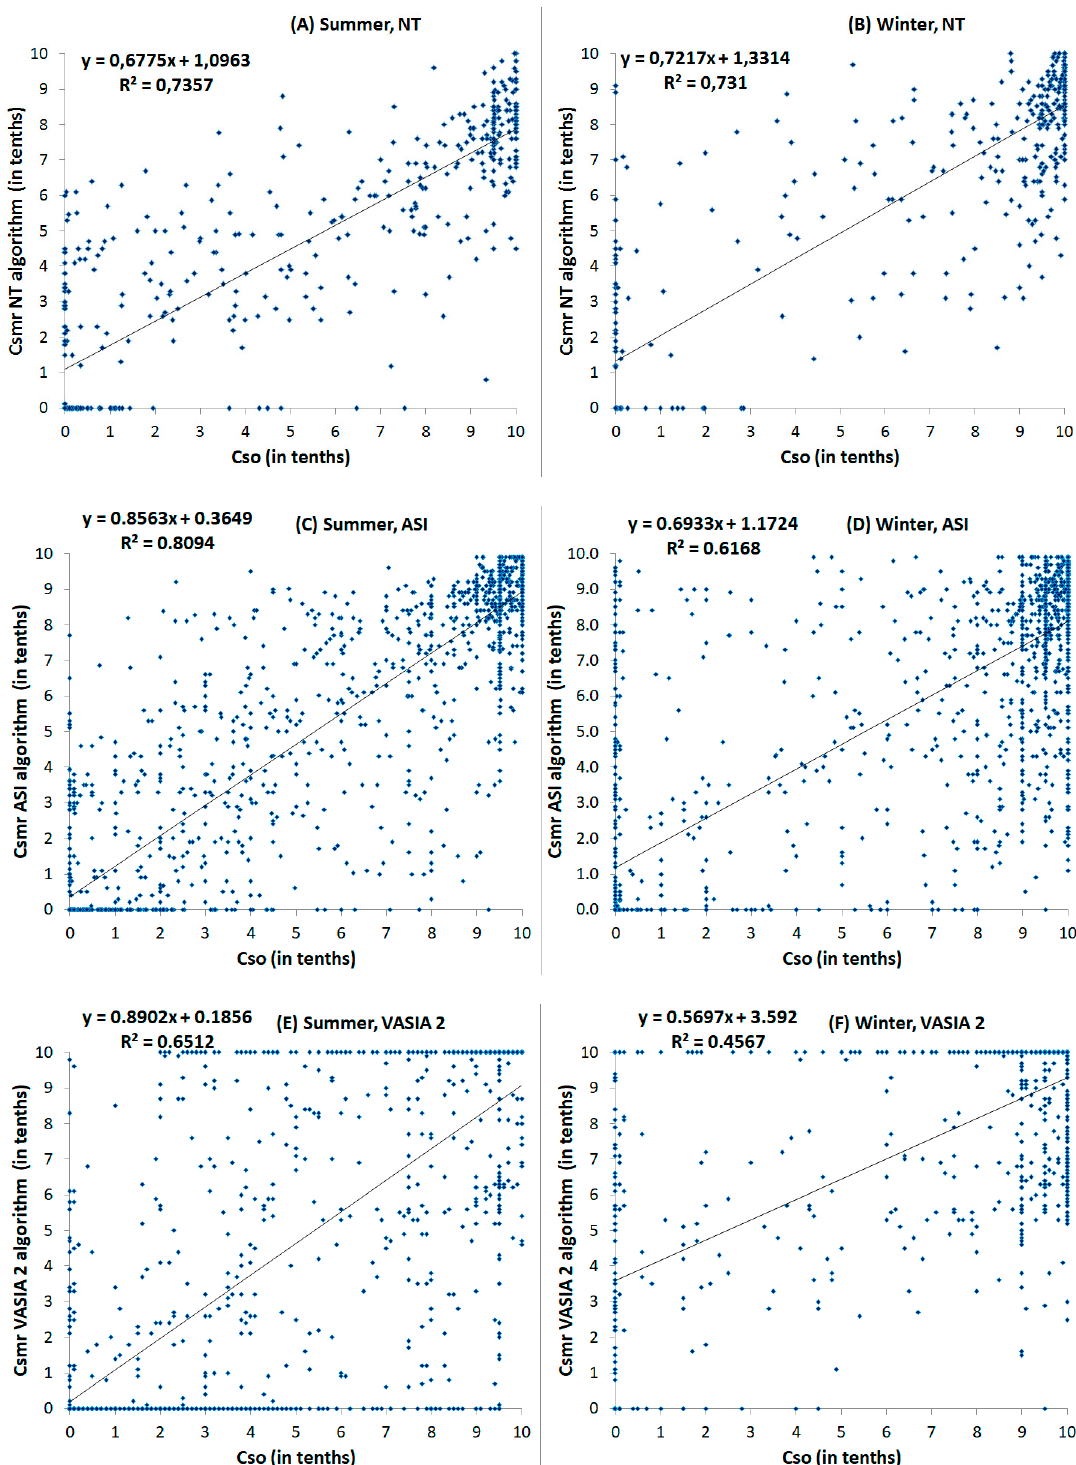
Figure 10. ( A – F ) Observed C so vs SIC derived by NT, ASI, and VASIA2 in summer and winter .